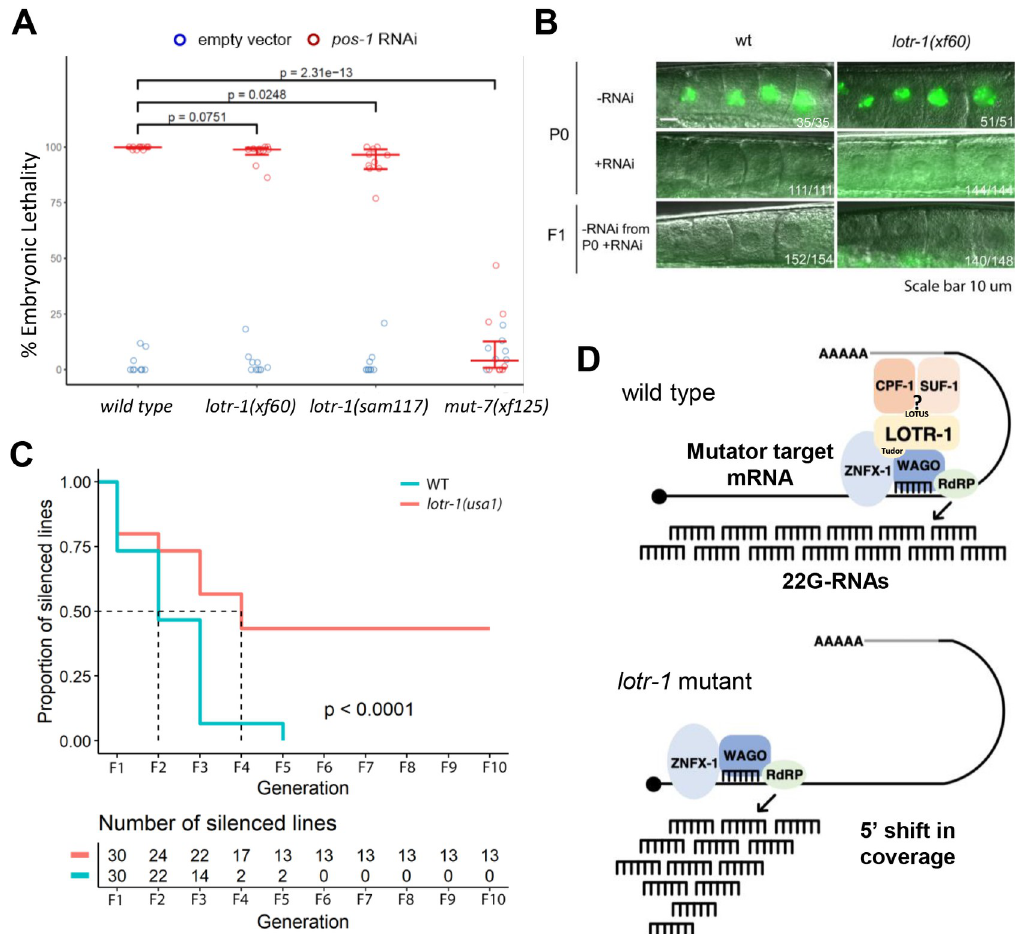
Fig 5. RNAi sensitivity and inheritance in lotr-1 mutants. A) Sensitivity of two different lotr-1 mutant alleles against pos-1 RNAi, using mut-7(xf125) mutants as a known pos-1 RNAi resistant control. Hatching proportion (y-axis) was scored; horizontal blue lines represent the fitted hatching probabilities. P-values were determined using Likelihood Ratio Tests. Error bars: bootstrap 95% confidence intervals for hatching probabilities. B) Inheritance of RNAi was tested using RNAi against GFP, targeting a transgene expressing a GFP::histone2B fusion ( mjIS31 ) in oocytes [50]. Silencing in the treated P0 generation was fully effective, as was the inheritance of silencing to the F1. C) Transgenerational inheritance assay using RNAi against a GFP:: histone2B transgene (ruIs32) in WT and the deletion allele lotr-1(usa1 ) revealed enhanced silencing up to 10 generations in the absence of LOTR-1. D) A model summarizing how LOTR-1, together with ZNFX-1, could affect 22G RNA production from an RdRP-targeted transcript. We note that all interactions are based on IP-qMS and Y2H experiments. Since these techniques do not report on whether a given interaction reflects a stable complex, or rather a more transient type of interaction, further study will be required to define the precise composition and nature of the associated molecular